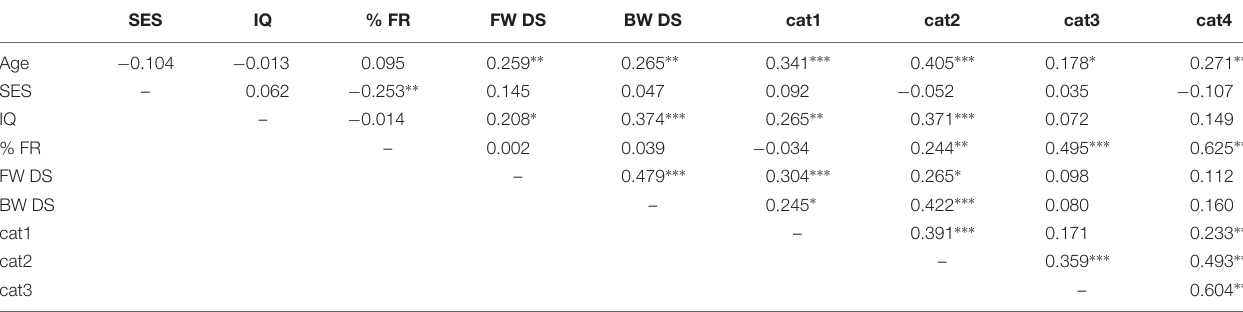
TABLE | Bivariate correlations among all variables at Time 1.